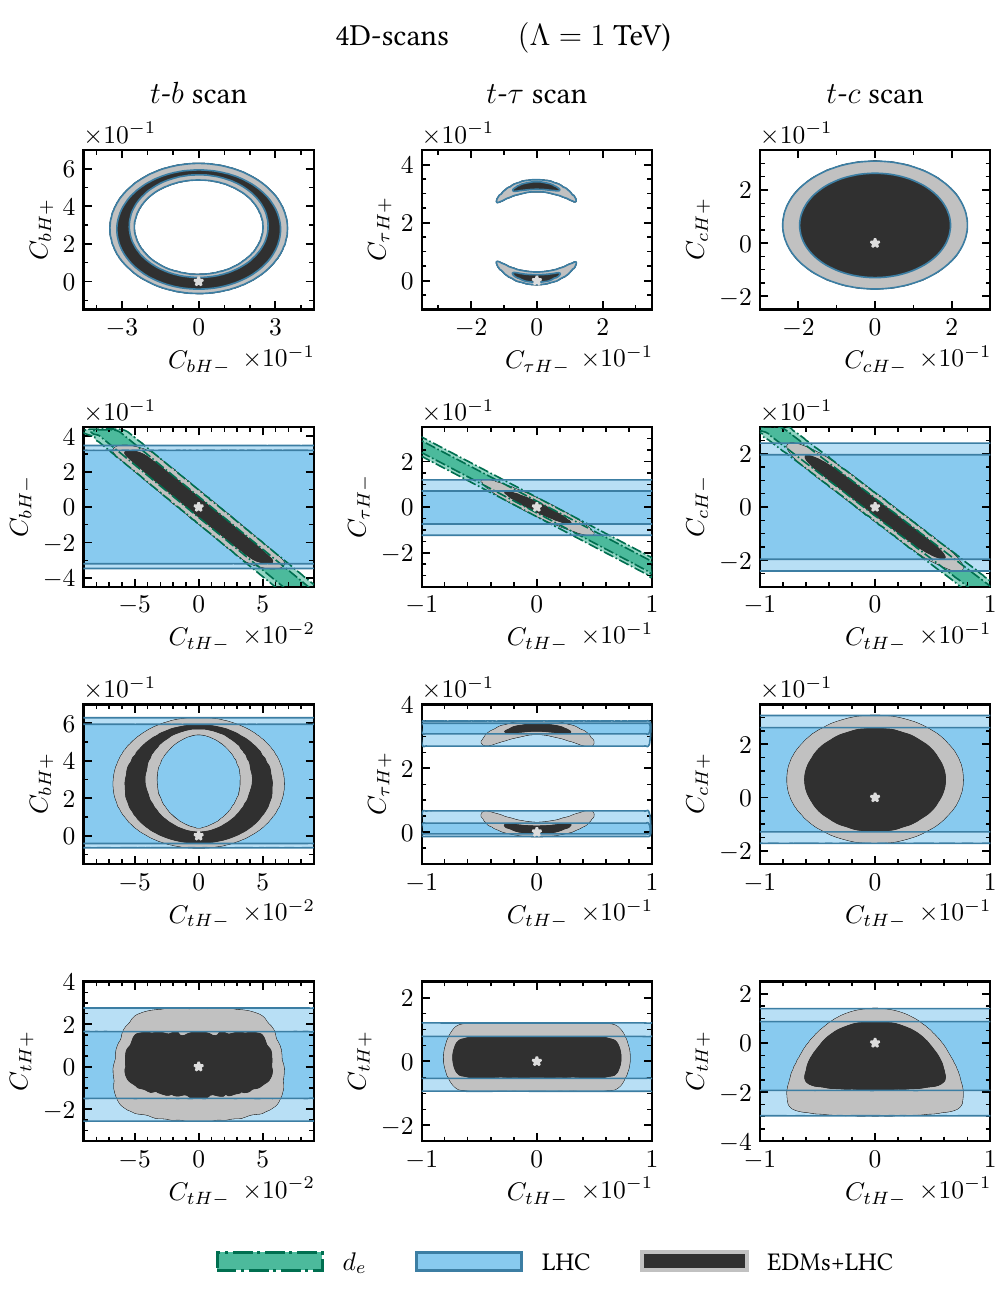
Figure 7 . Constraints resulting from a 4D scan of top and bottom coefficients ( C tH ± , C bH ± ; first column), top and tau coefficients ( C tH ± , C τH ± ; second column), and top and charm coefficients ( C tH ± , C cH ± ; third column), assuming Λ = 1 TeV. In each plot only two parameters are shown, the remaining two are profiled over (see main text). Contours represent the allowed 68% and 95% confidence regions, the colour coding of individual constraints is given in the legend, and grey/black areas correspond to the combined regions. For details see main text and the caption of figure